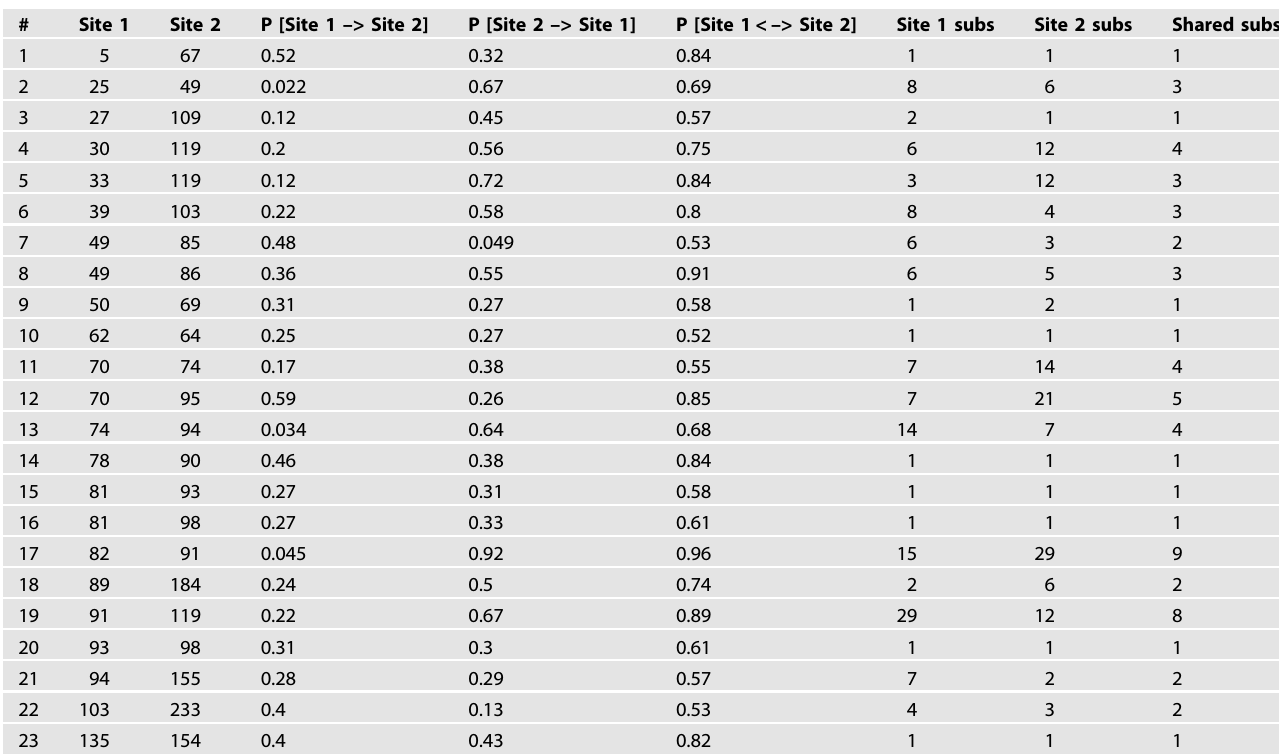
Table 2. The BGM analysis of BDNF found 23 pairs of coevolving sites out of 261 total sites to be statistically signi fi cant (with a posterior probability threshold of